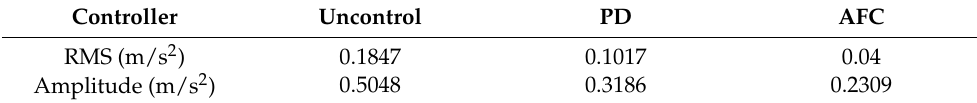
Figure 20. Experiment result of acceleration response for case 1. Table 4. Vibration suppression effect of the experimental system for case 1.